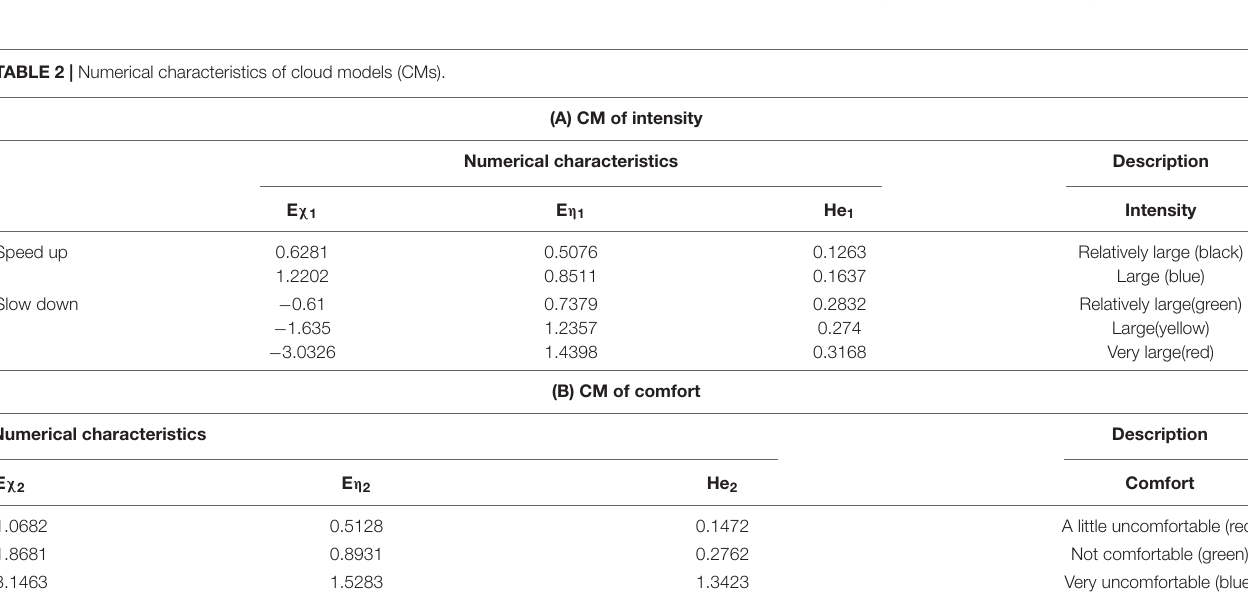
(A) In the column of “Intensity,” the color in the parentheses is correspond to the color of cloud in Figure 5A . (B) In the column of “comfort,” the color in the parentheses is correspond to the color of cloud in Figure 5B